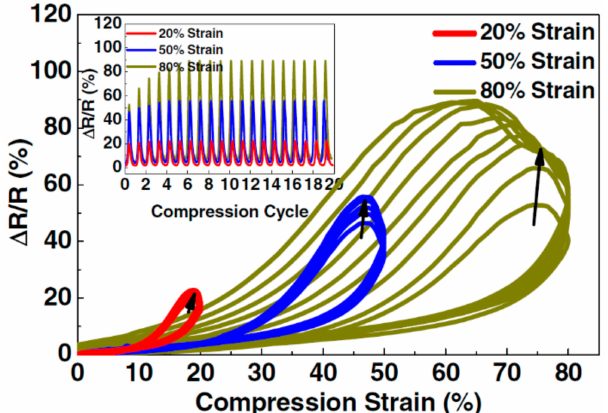
Figure 12. Electrical resistance of graphene aerogel / PDMS composites subjected to compression strain. Reproduced with permission from [114]. Copyright 2015,